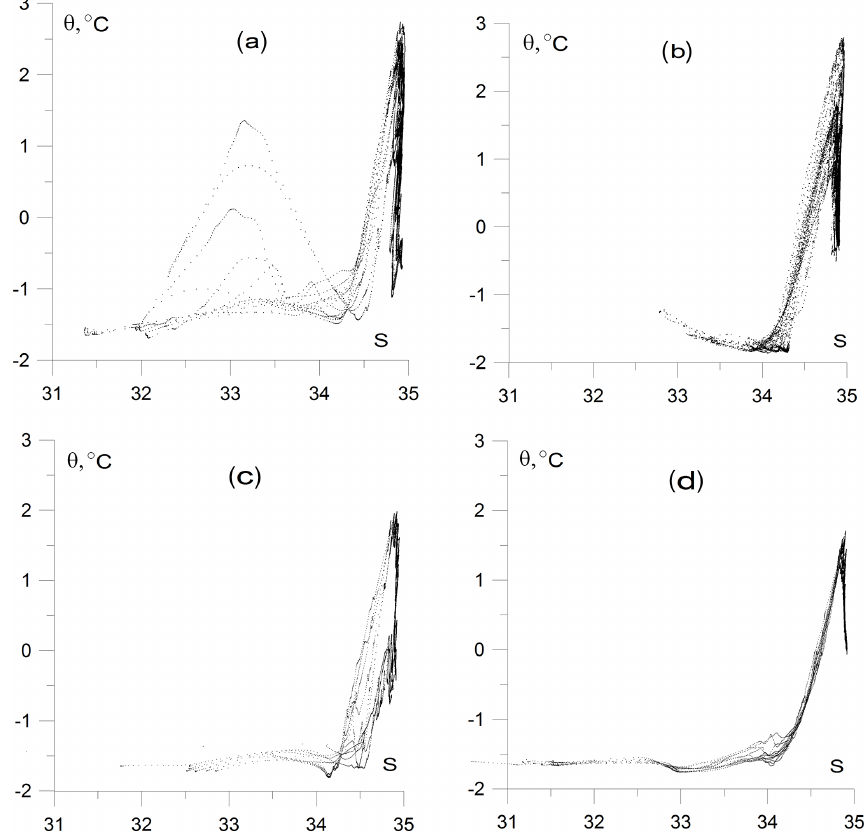
Figure 7. θ – S diagrams based on the CTD profiling in (a) the St. Anna Trough (NABOS09, 82 ◦ N), (b) the PS96 section at 92 ◦ E, and the NABOS09 sections at 103 ◦ E (c) and 142 ◦ E (d) . For convenience of presentation, the points of the θ – S curves with salinity below 30 were